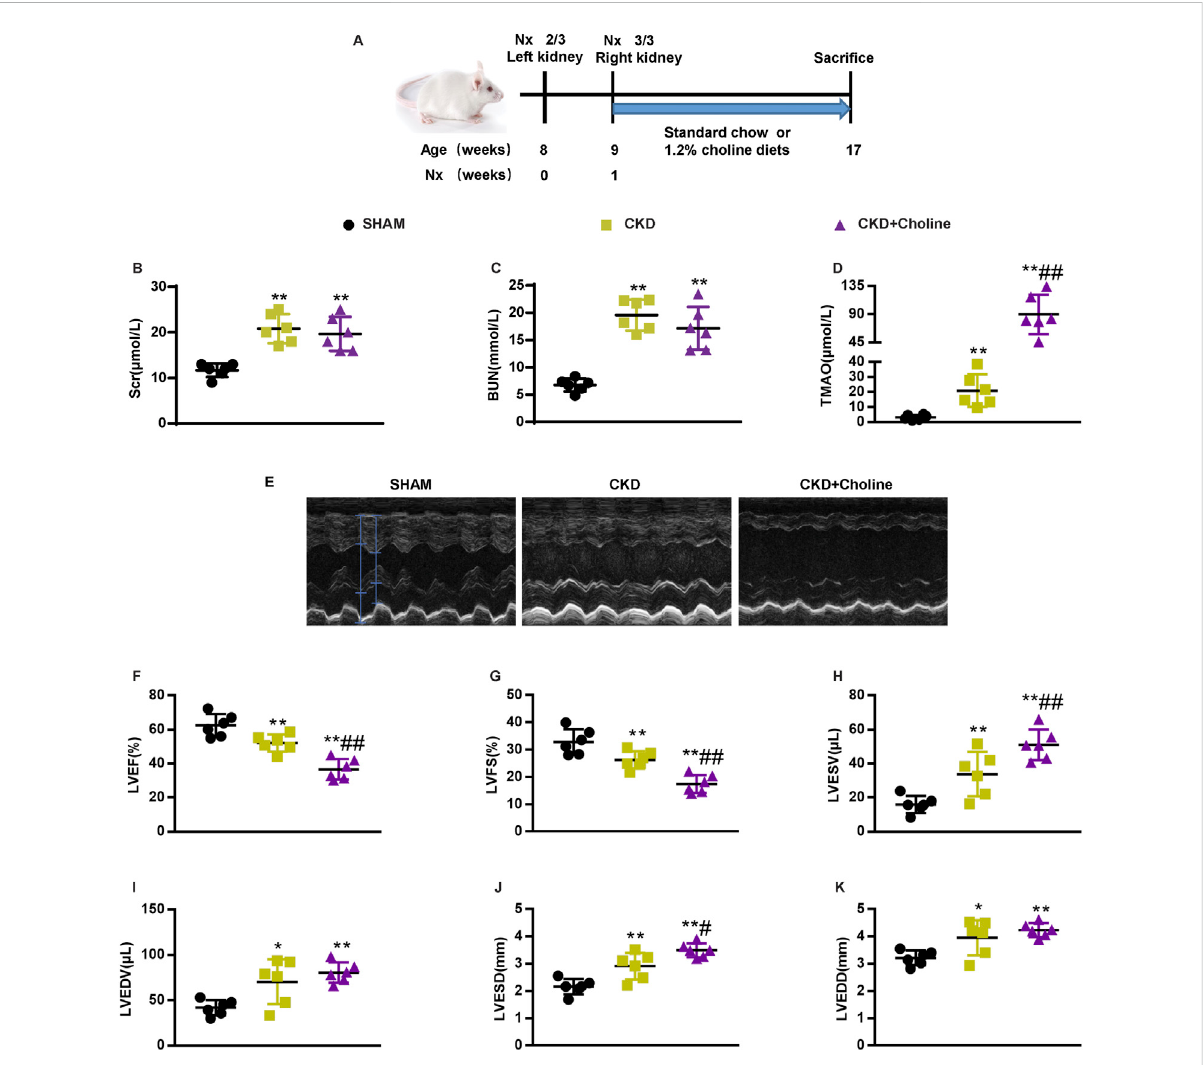
FIGURE 1 Dietary choline (1.2%) exacerbates cardiac dilation and dysfunction after 5/6 nephrectomy(5/6Nx) inCD1 mice when compared with a control diet. (A) Schematic design of CKD animal model (5/6 Nx) and treatments (B) The serum level of TMAO. (C) The serum level of serum creatinine (Scr). (D) The serum level of blood urea nitrogen (BUN). (E) Representative M-mode echocardiograms for each group. (F – K) Echocardiographic quanti fi cation of left ventricular ejection fraction (LVEF %), LV fractional shortening (LVFS %), LV end-systolic volume (LVESV; in μ L), LV end- diastolic volume (LVEDV; in μ L), LV end-systolic diameter (LVESD; in mm), and LV end-diastolic diameter (LVEDD; in mm). The data are presented as the mean ± SD. * p < 0.05 and ** p < 0.01 vs. SHAM group; # p < 0.05 and ## p < 0.01 vs. CKD group. n = 6 in each